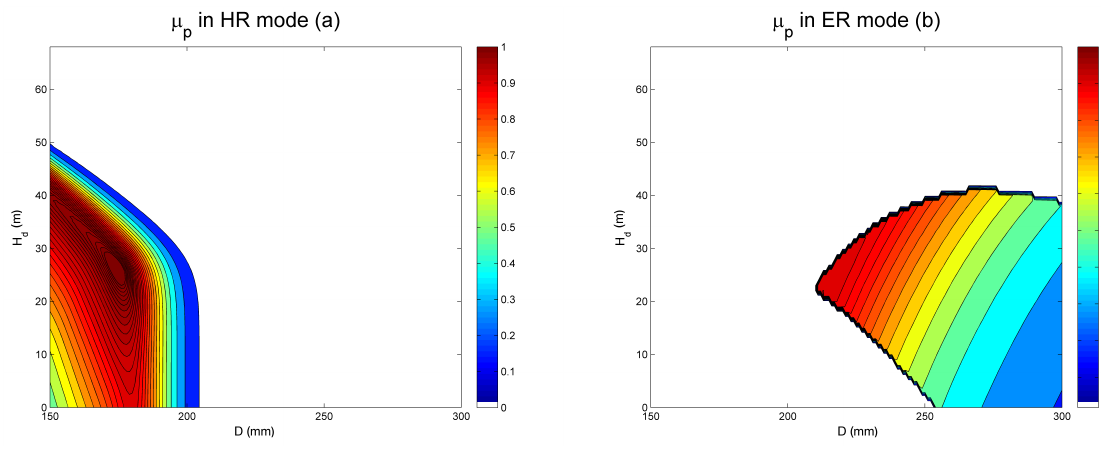
Figure 8. E values resulting from VOS: ( a ) HR mode and ( b ) ER